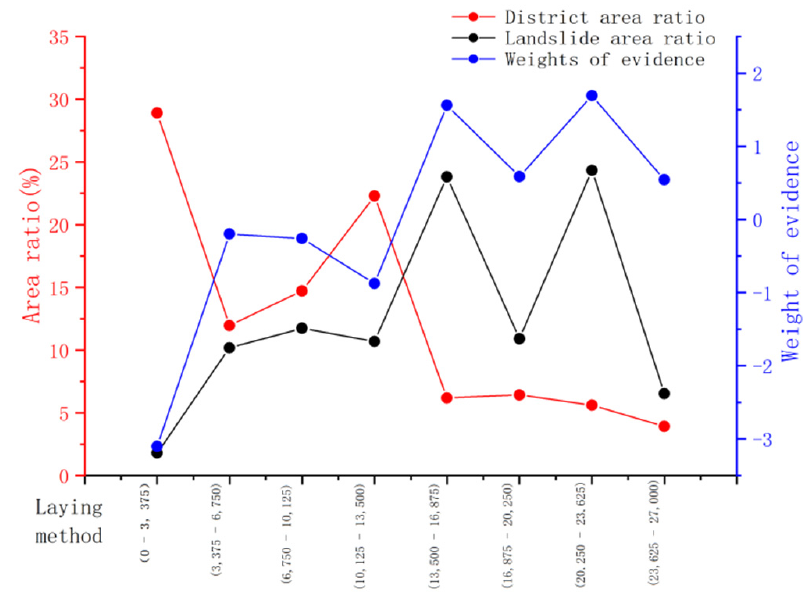
Figure 11. Statistical analysis results of laying method.